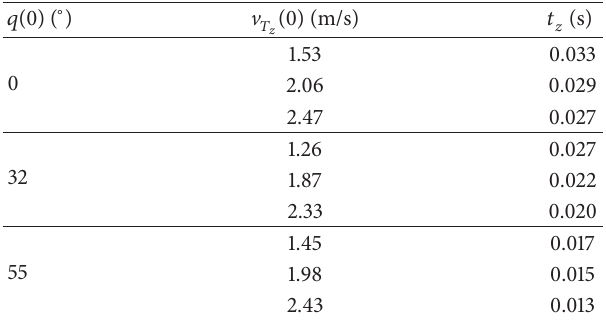
Table 1: Stopping time for the free